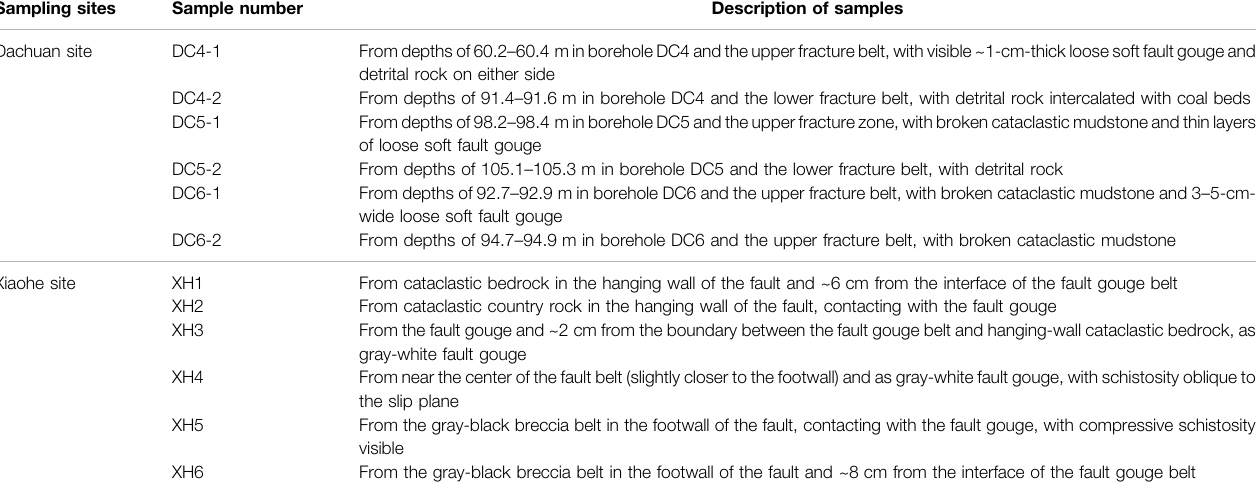
TABLE 1 | Descriptions of fault gouge samples from the DSF.